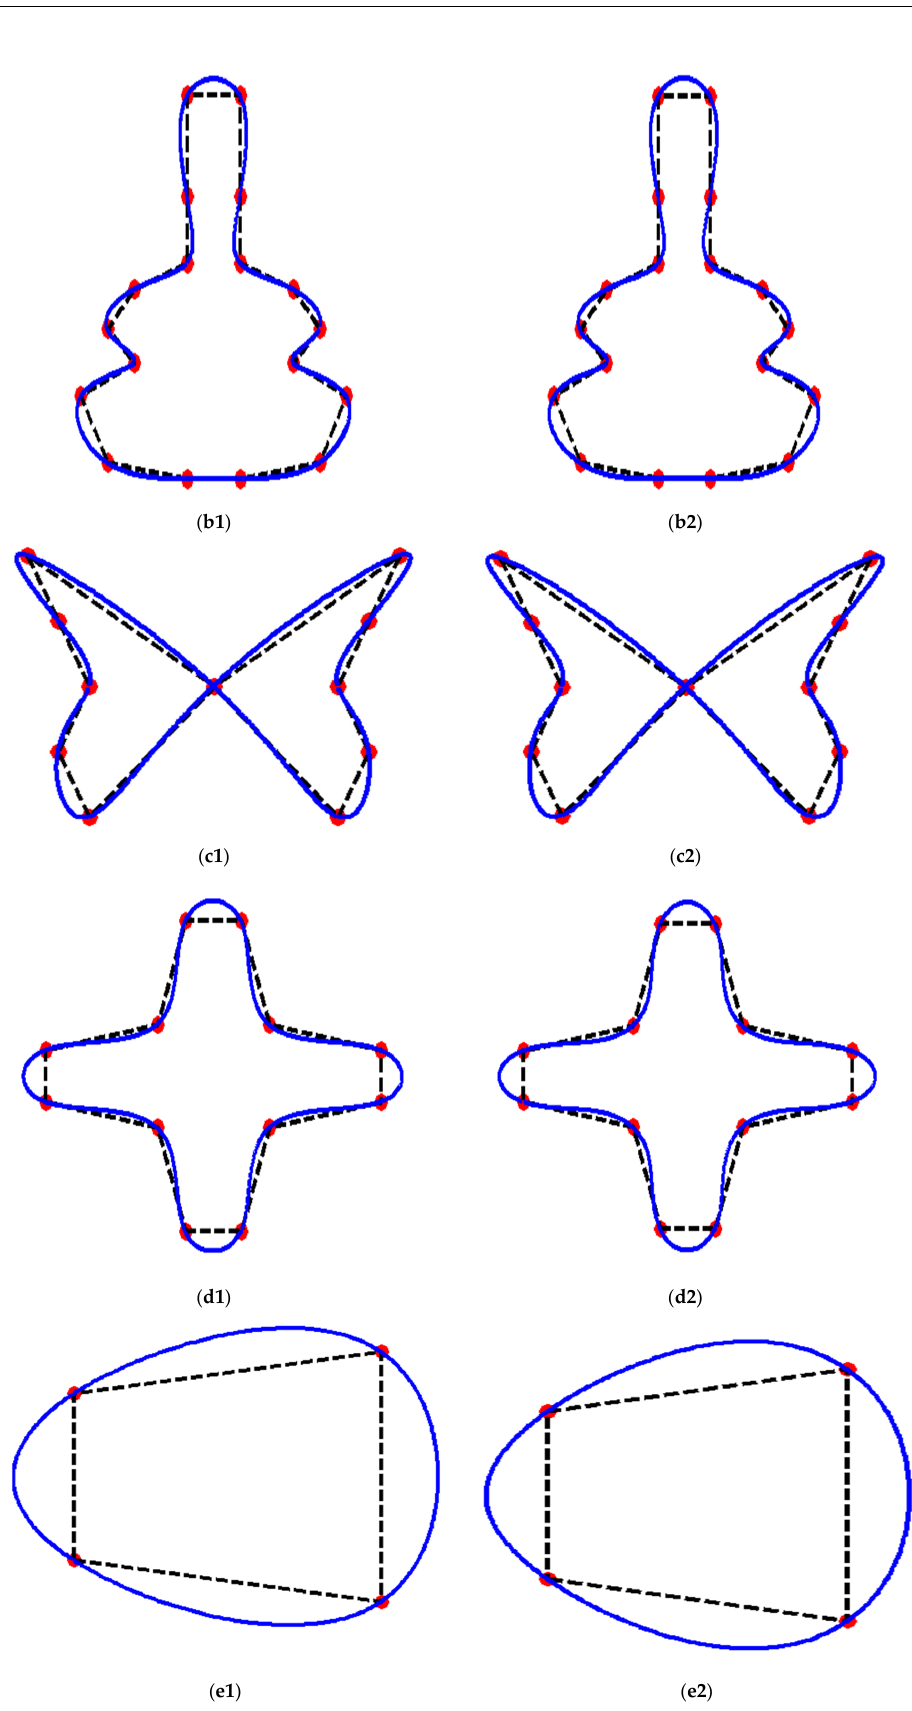
Figure 15. Different objects ( a1 , b1 , c1 , d1 , e1 ) are interpolated using RCS and ( a2 , b2 , c2 , d2 , e2 ) using RQTS.